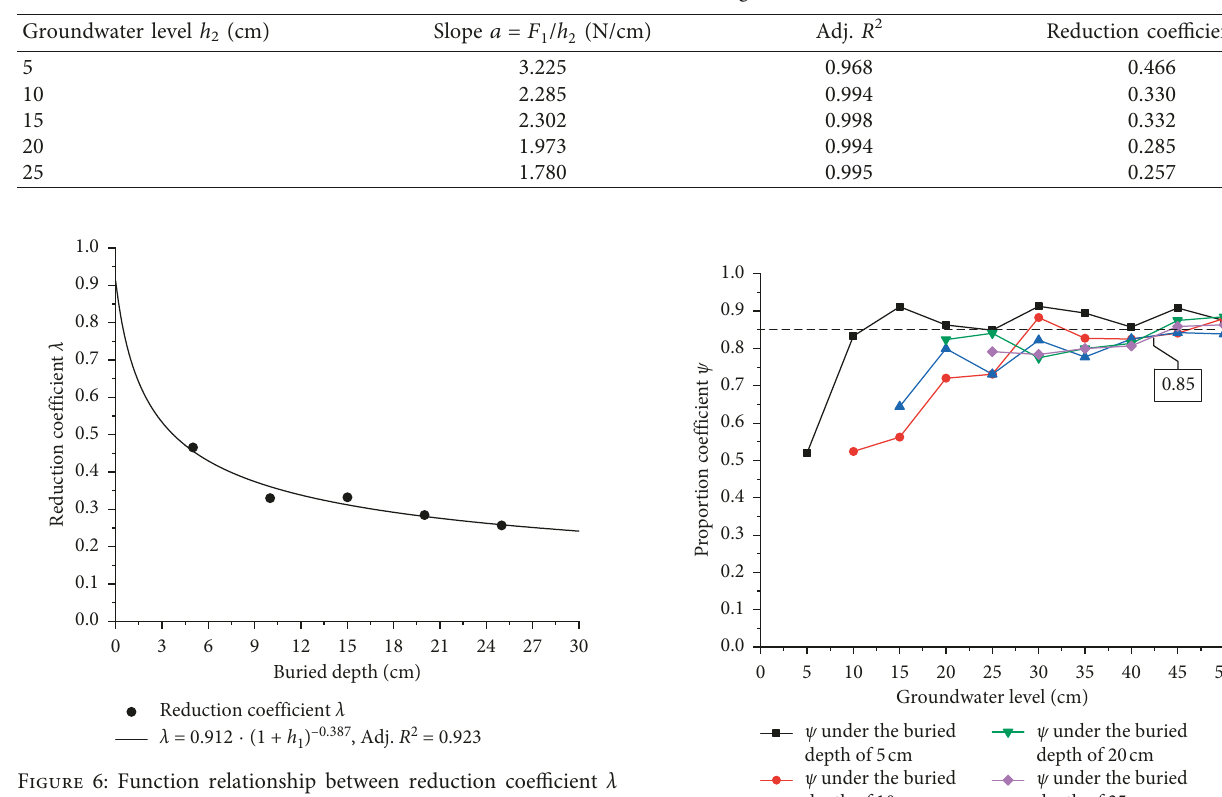
Figure 5: Fitting line of the experimental groundwater buoyancy with the groundwater level under different buried depths: (a) 5cm, (b) 10cm, (c) 15cm, (d) 20cm, and (e) 25cm. Table 3: Parameters of the fitting formulas.